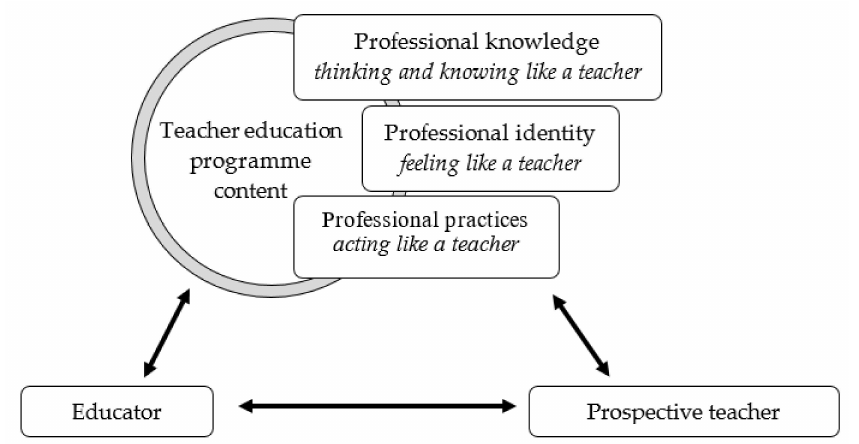
Figure 2. The teaching triangle in initial teacher education.